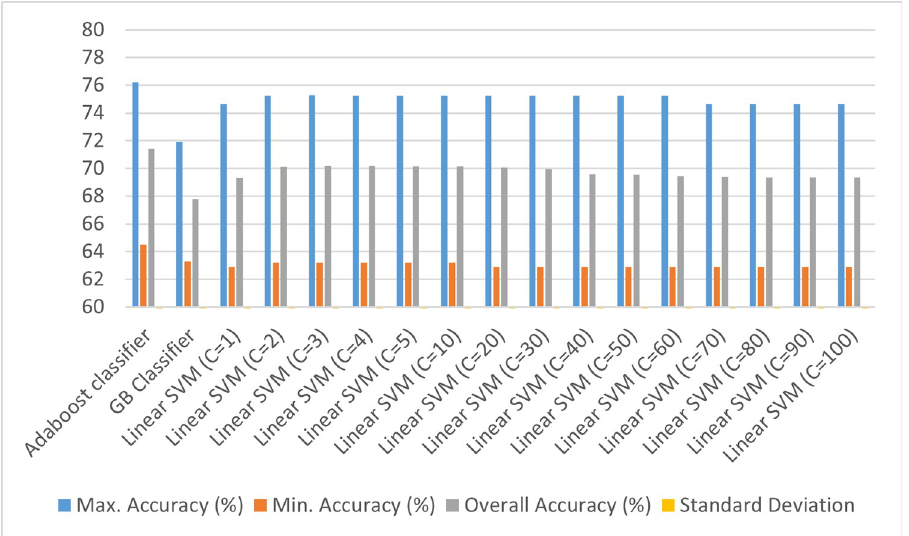
Fig 2. Classification results using baseline model (without any feature engineering